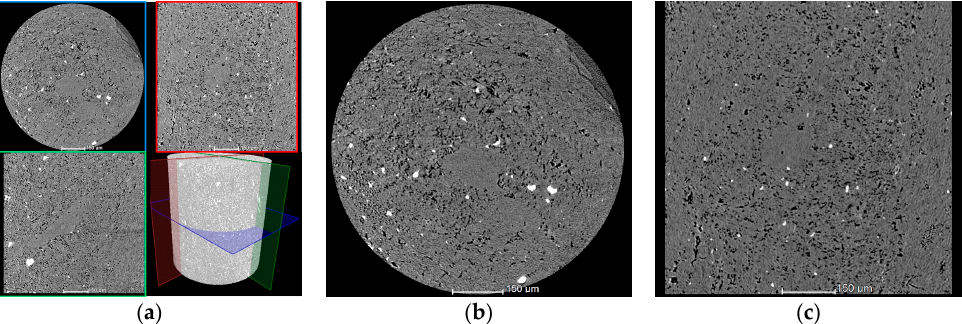
Figure 3. Profile image of the reconstructed 3D model: ( a ) Four-View; ( b ) 512th layer profile on the XY plane; and ( c ) 420th layer profile on the ZY plane.